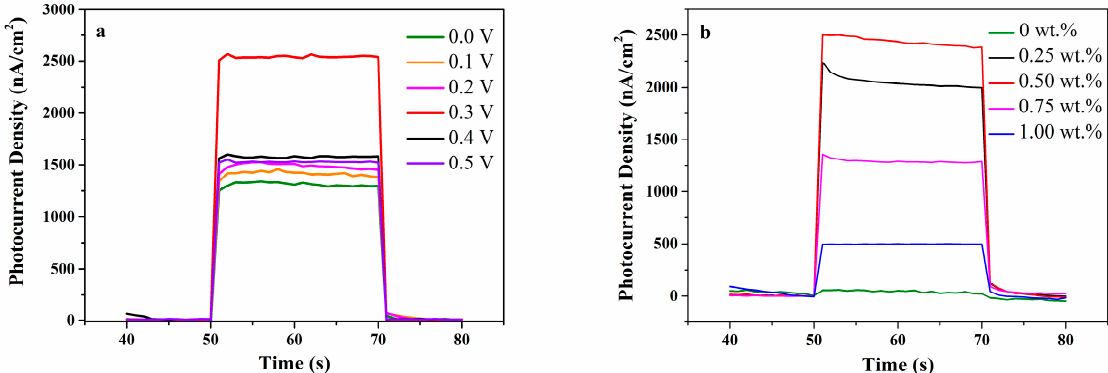
Figure 6. ( a ) Photocurrent–time responses at different bias voltages in 0.1M NaOH, and ( b ) photo- current–time responses of different gold loading of Au/TiO 2 NTs in 0.1M NaOH at 0.3